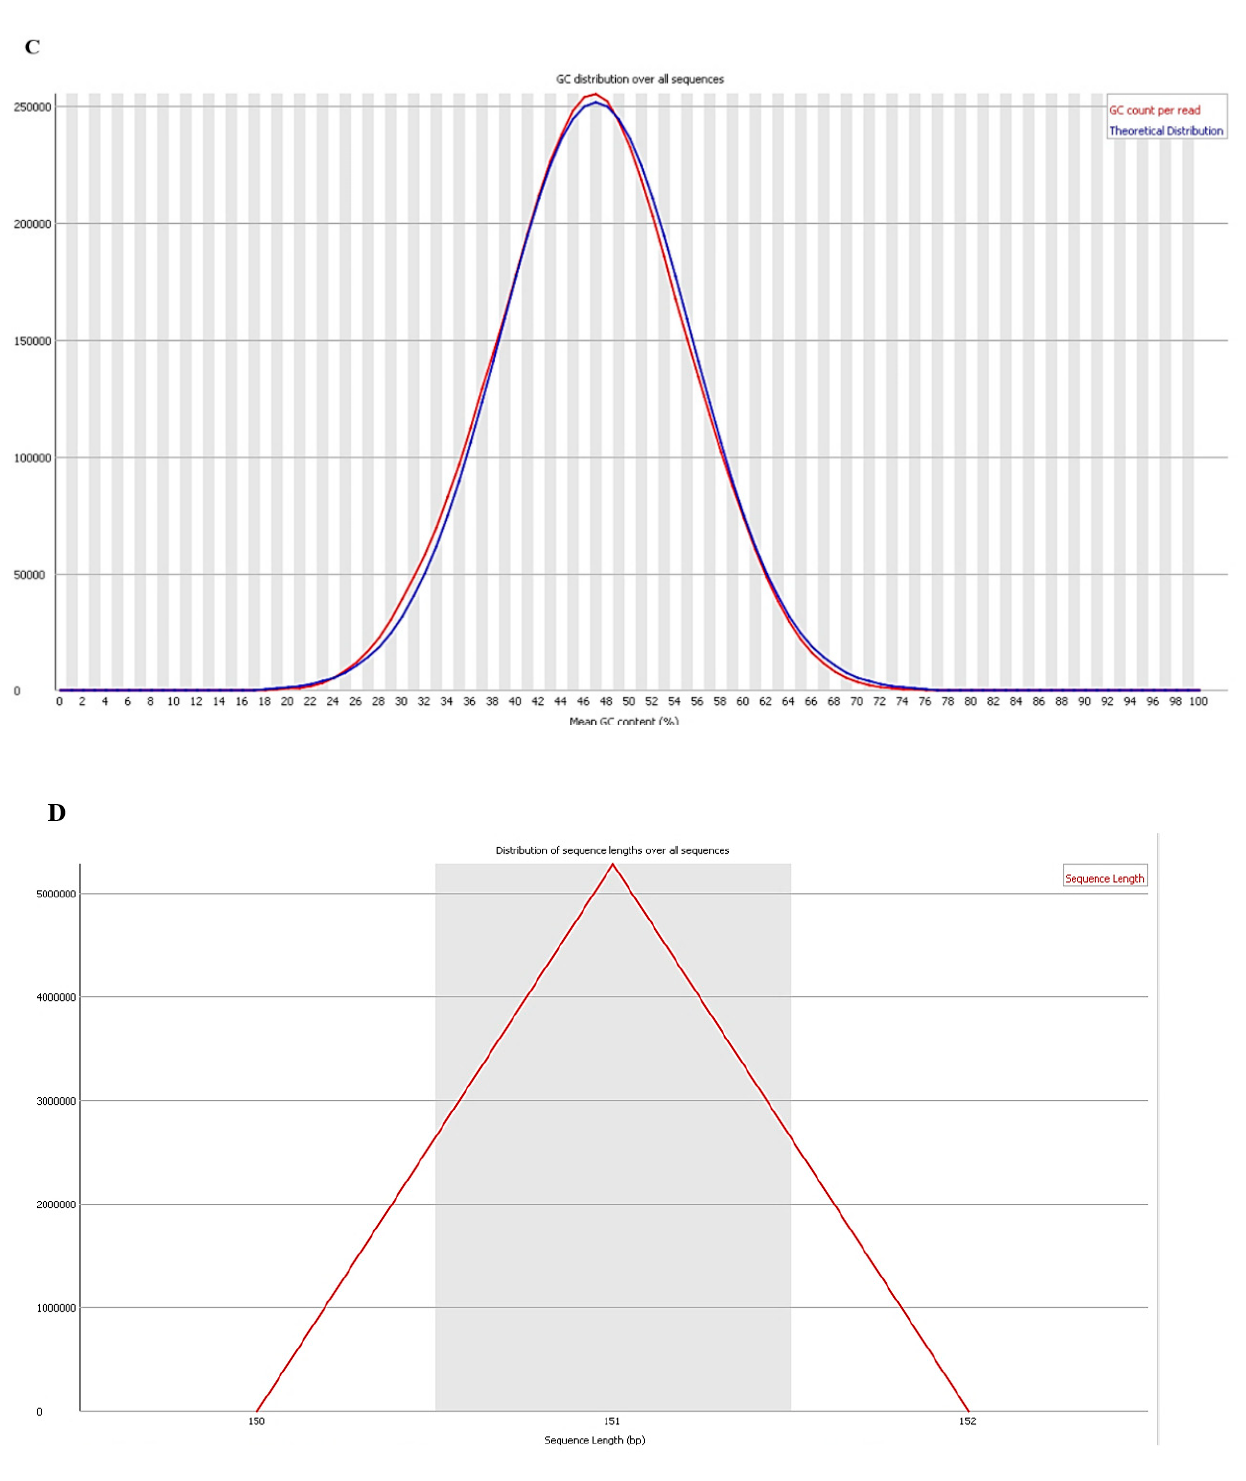
Figure 1. Quality assessment of reads. ( A ) Per base sequence quality. ( B ) Per base quality score. ( C ) Per sequence CG-Content. ( D ) Sequence length distribution.